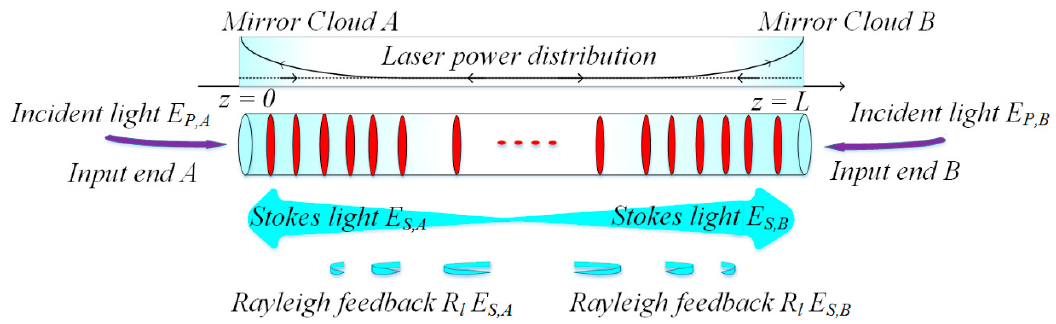
Figure 3. Configuration of random fiber F-P resonator-based Brillouin random fiber laser (RFL).